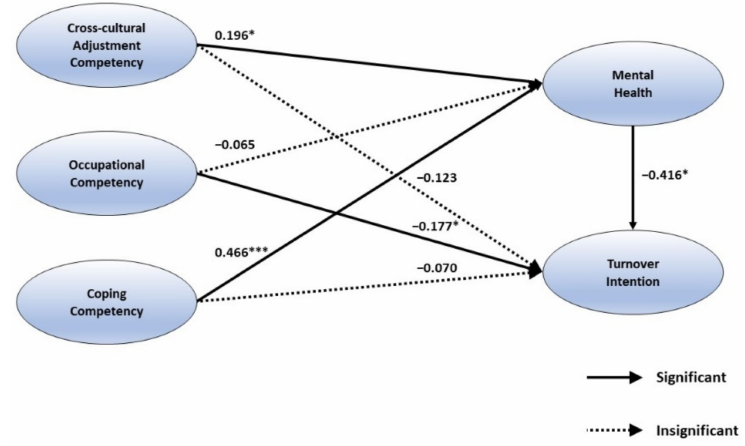
Figure 2. Structural model result. Note: * p < 0.05, *** p <